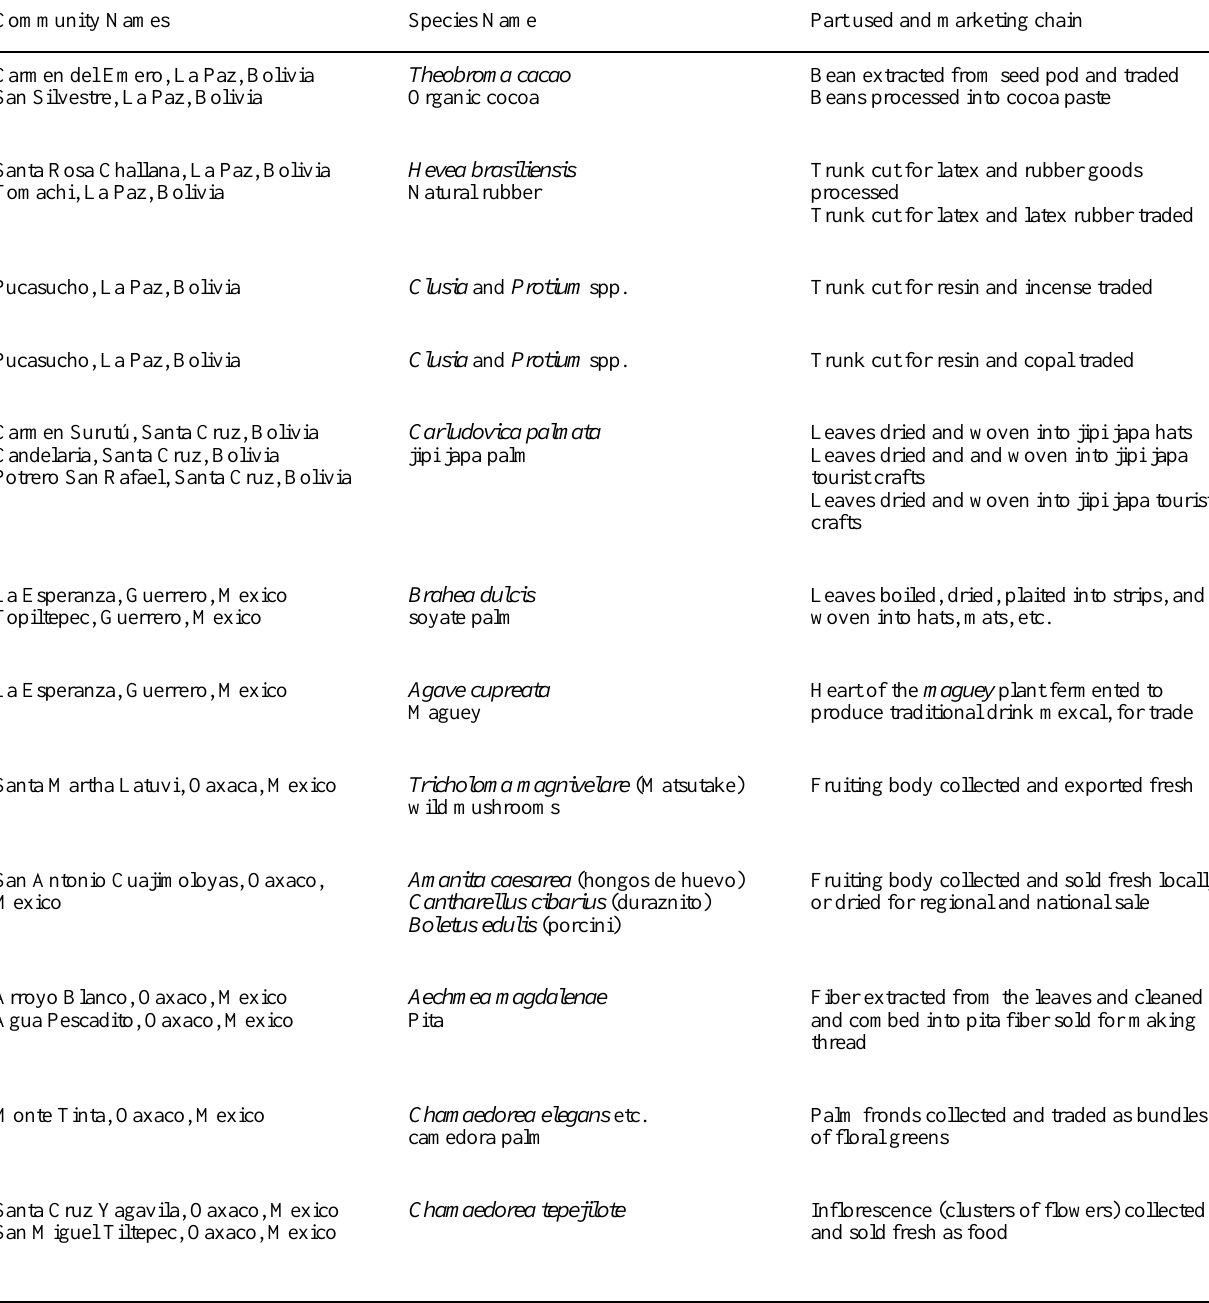
Table 1. Details of the case studies included in the CEPFOR project, which formed the basis of the BBN. Community